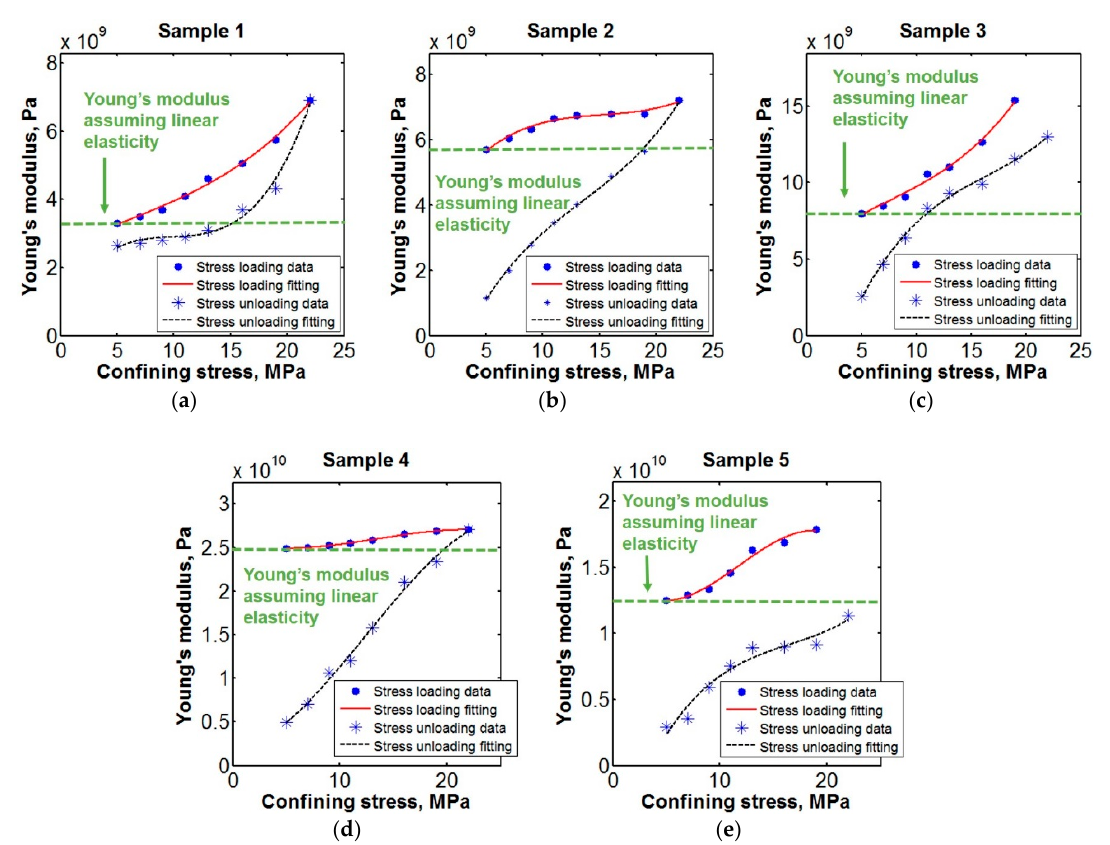
Figure 5. Calibrated correlations between Young’s modulus and confining stress and the curve fittings.